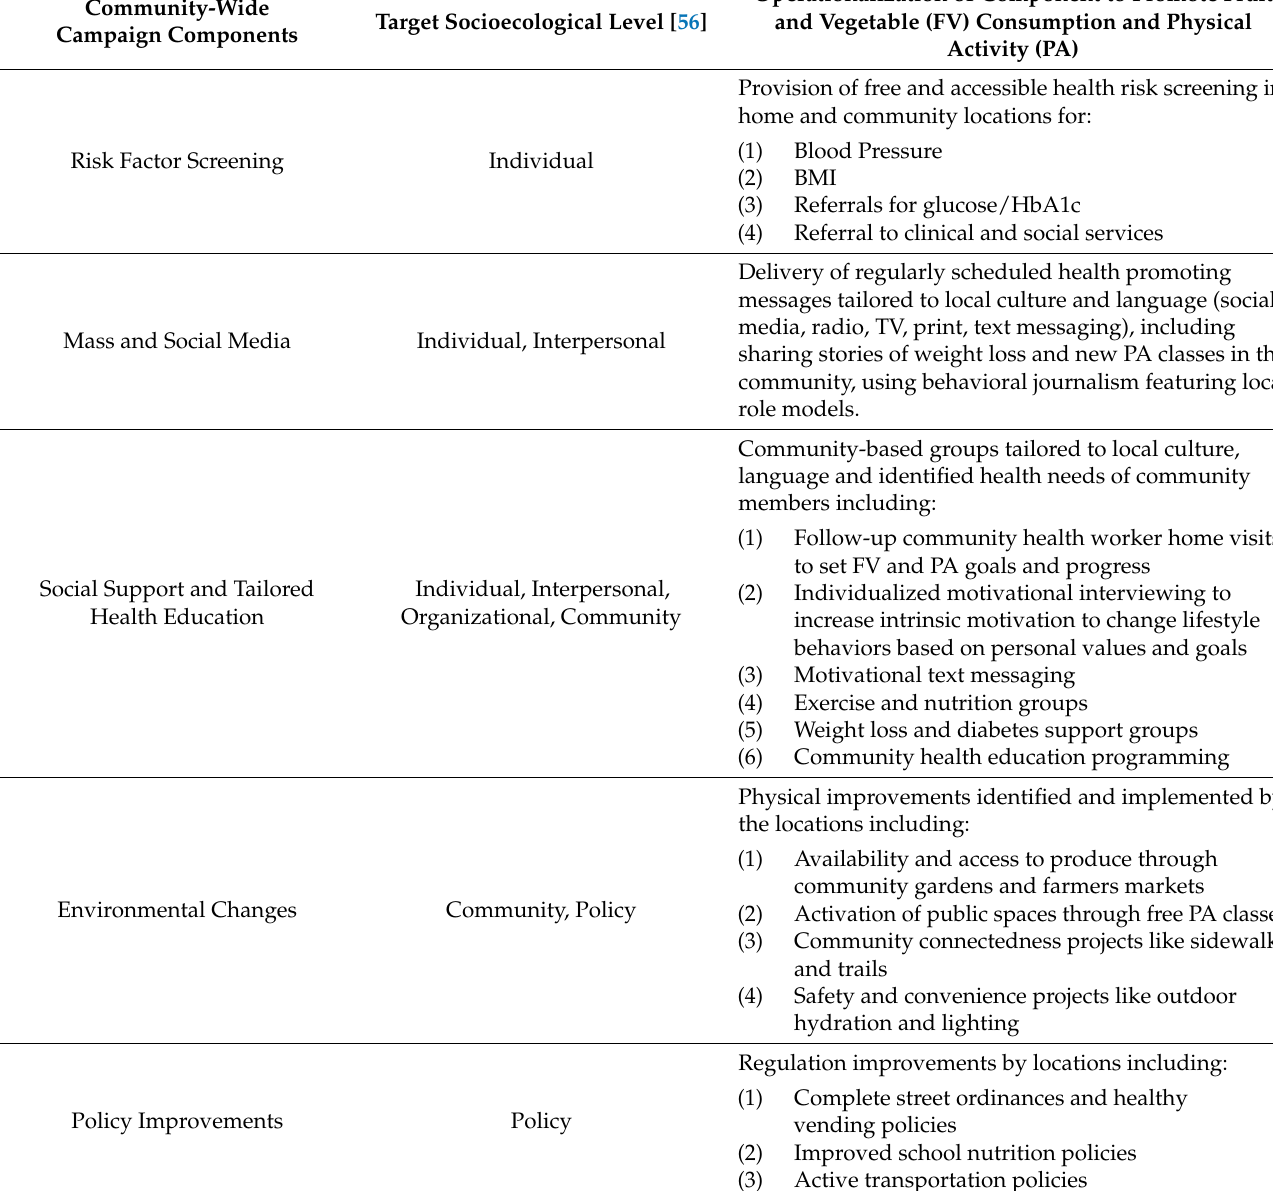
Table 1. Tu Salud ¡Si Cuenta! Community-Wide Campaign Program